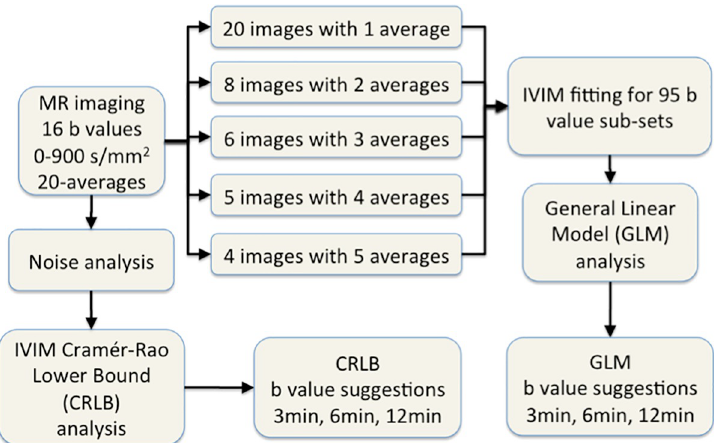
Fig 1. Analysis workflow for optimization of brain IVIM model for number of b values up to 900 s/mm 2 , using 20 repeated scans in four healthy volunteers, with two optimization strategies of General Linear Modelling (GLM) of standard deviation measurements in 95 b value settings, and Crame´r-Rao Lower Bound analysis using noise measurements in the same data.